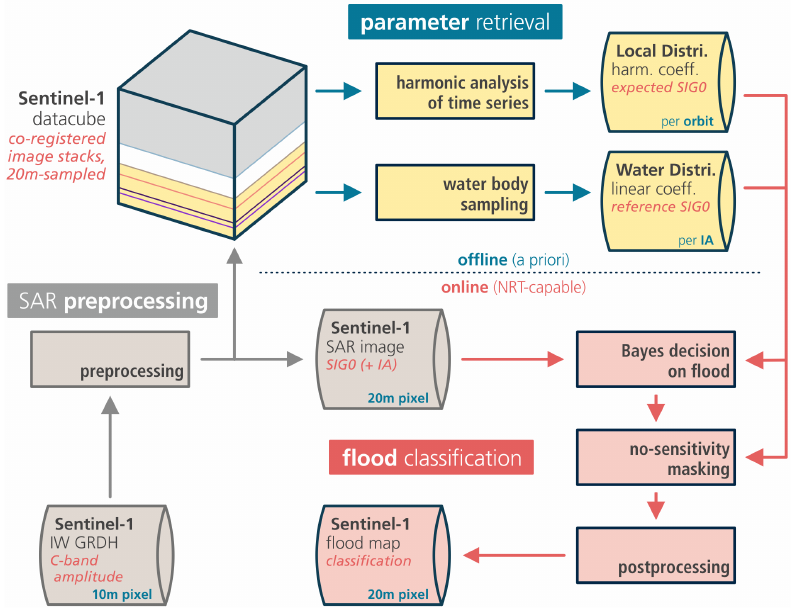
Figure 1. Schematic overview of the flood mapping algorithm’s main components and data flow. Gray module: SAR preprocessing (not subject of this publication); blue module: offline/precomputed parameter retrieval; red module: the online/NRT flood classification. SIG0: sigma nought backscatter coefficient ( σ 0 ). IA: incidence angle ( θ